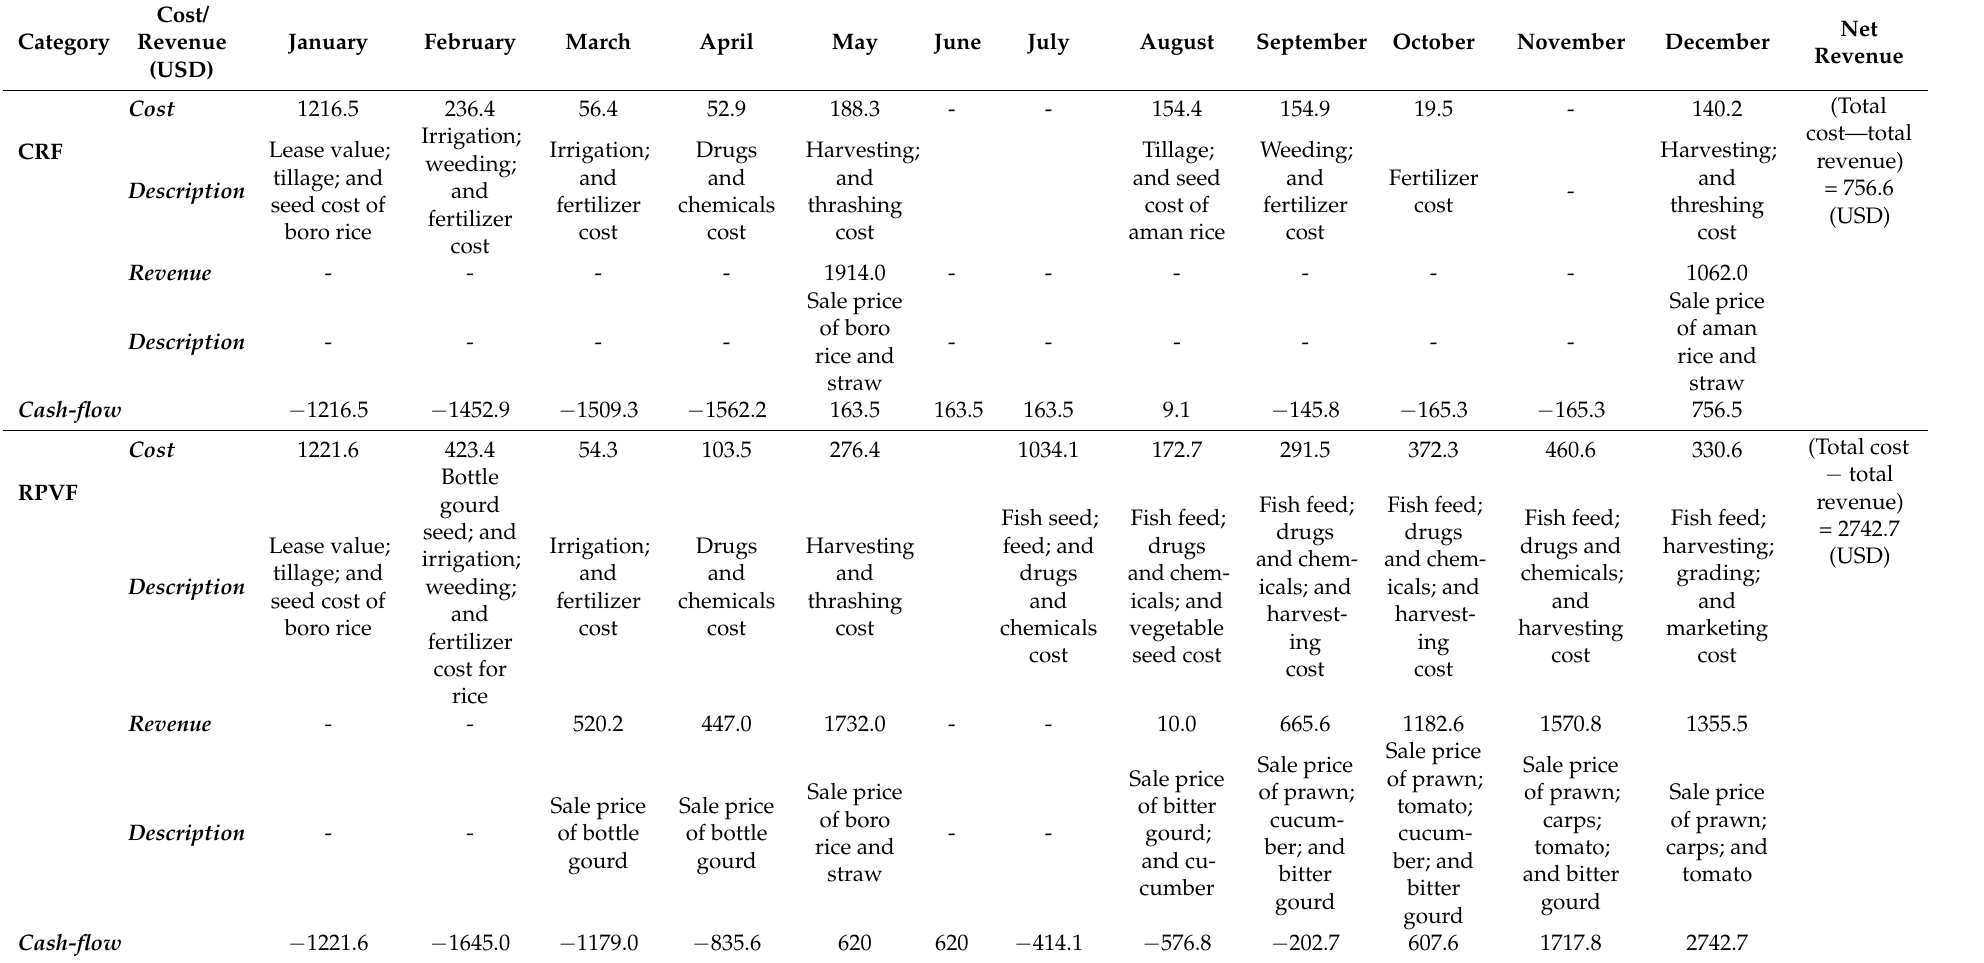
Table 6. Cash-flow analysis between conventional rice farms (CRF) and rice–prawn–vegetable farms (RPVF) (ha − 1 year − 1